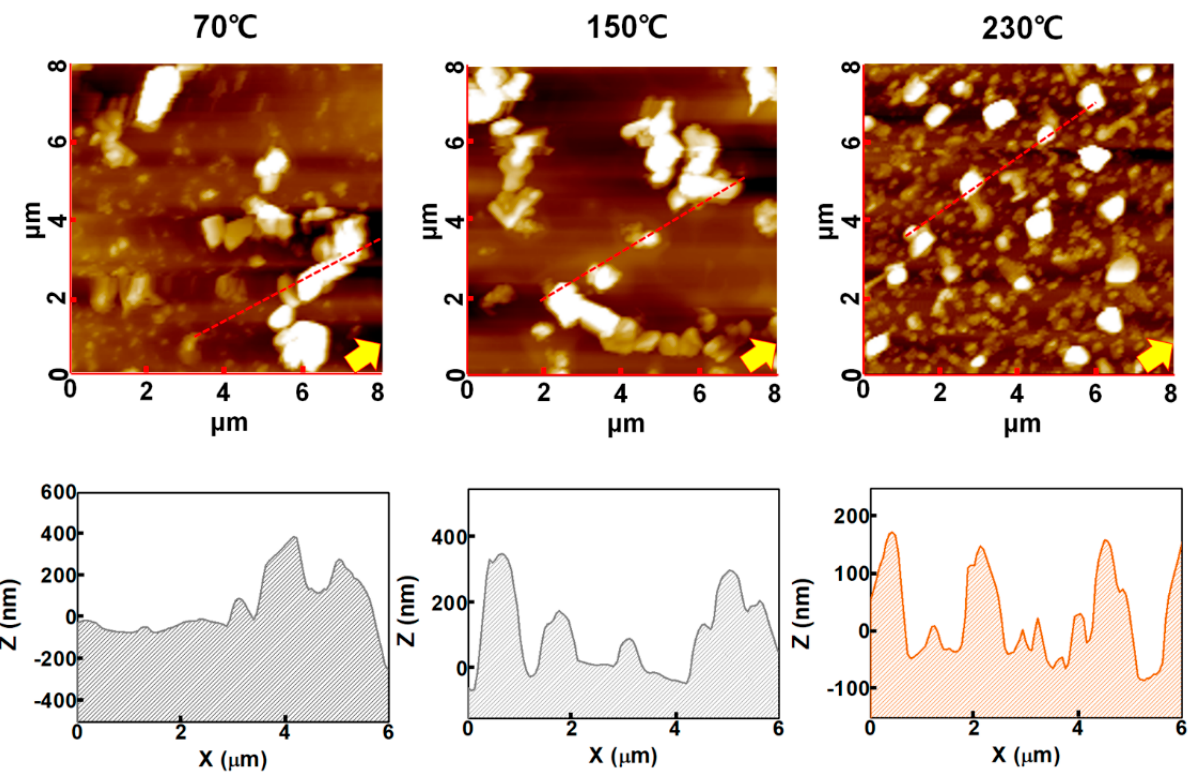
Figure 2. Atomic force microscopy images and corresponding line profiles of the brush − coated nickel yttrium oxide films cured at 70, 150, and 230 °C (The red dotted line corresponds to the line profile data). Direction of brush coating is denoted by a yellow arrow.